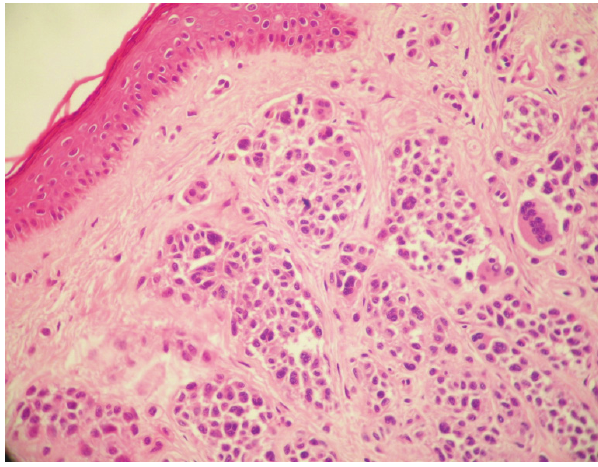
Figure 2 - Photomicrography on H/E - 400x – showing the cellular and nuclear pleomorphism, hyperchromatism and multi nucleation.